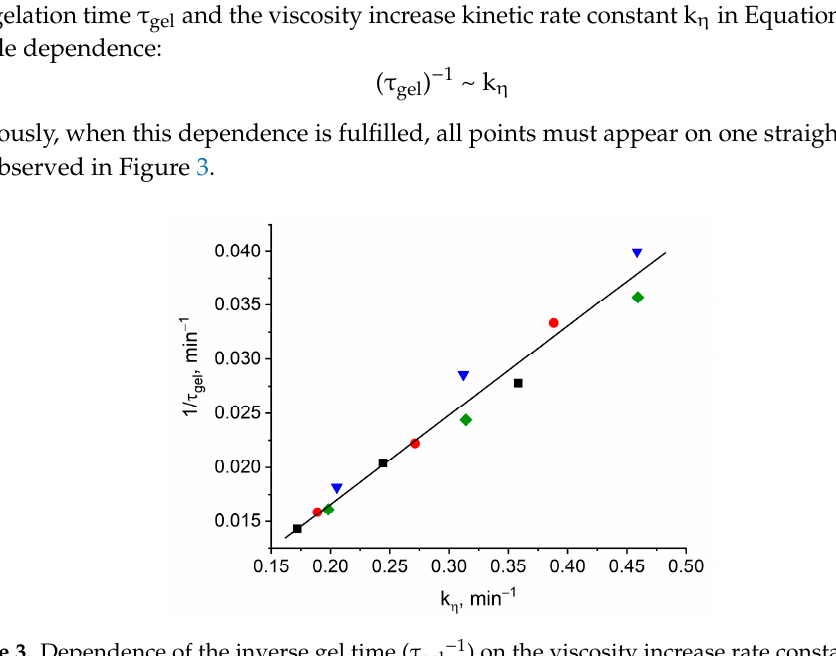
Table 4. Values of activation energies ( Е η ) for systems 1–4, calculated by the viscosity increase rate constantand by the time of gelation.